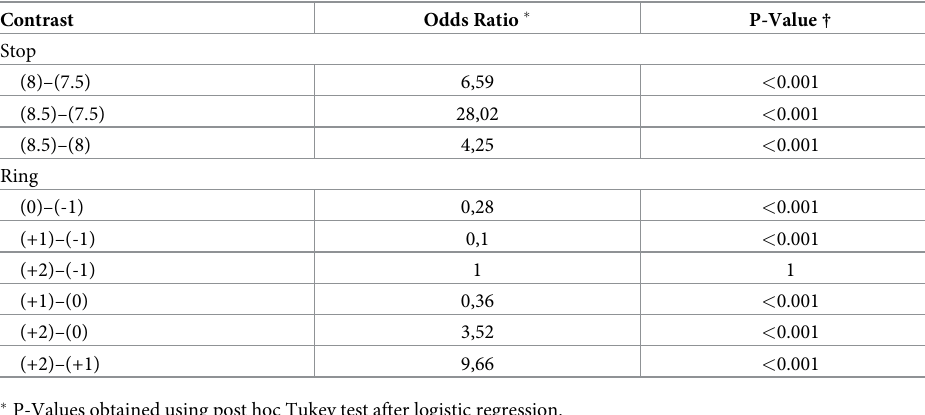
Table 2. Odds ratios of rings, stops and free flap incidence. Contrast